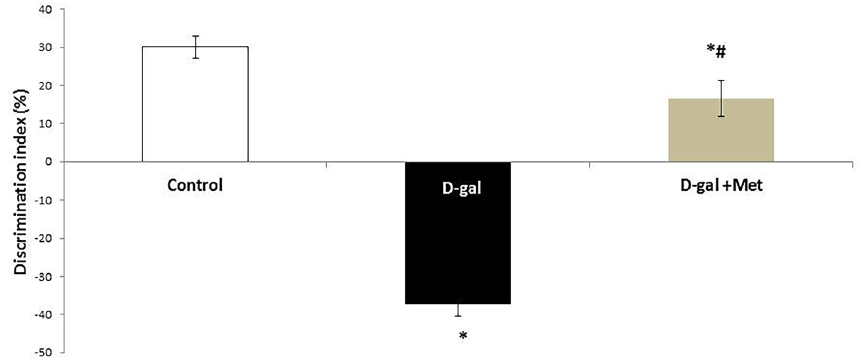
Figure 1. Effect of metformin on working memory and preference for novelty in d-galactose-induced aging rat model in novel object test (*significant when compared to control group, # significant when compared to D-gal group). Data are shown as means + SD (n = 10). ANOVA was used to make group comparisons; Significance = P <